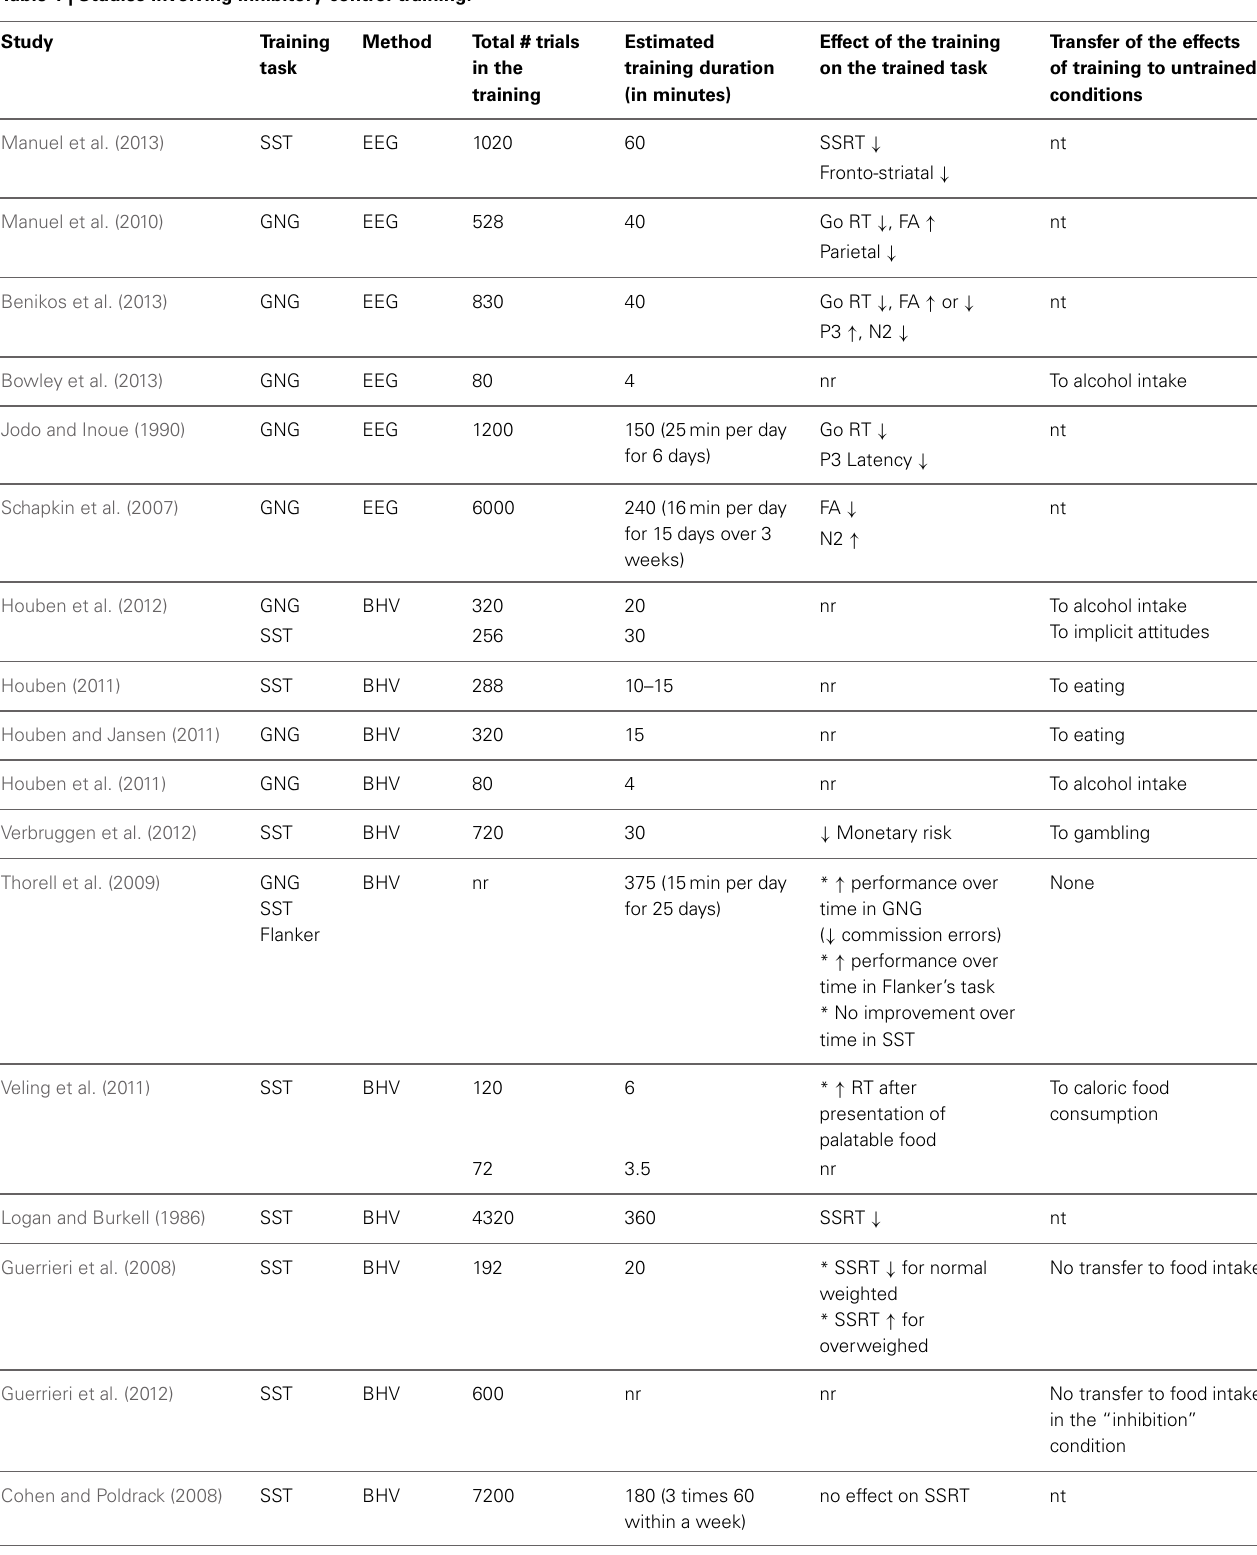
Table 1 | Studies involving inhibitory control